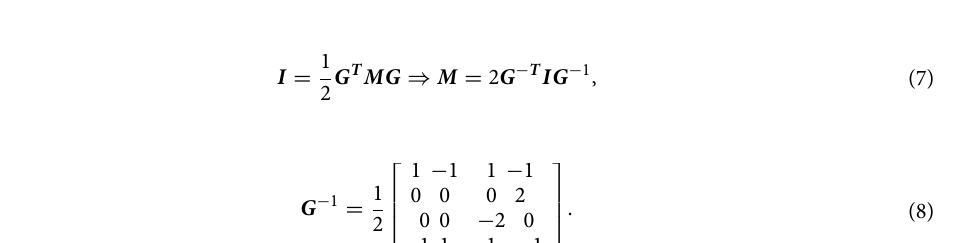
Figure 3. Mueller matrix of the laser